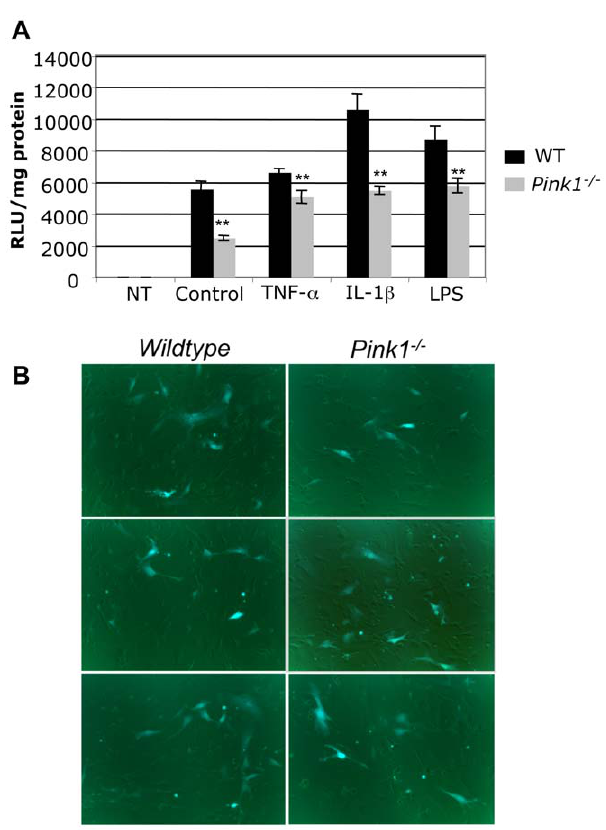
Figure 7. Basal and inflammatory signal-induced NF- k B activity is reduced in Pink1 2 / 2 embryonic fibroblasts. Wildtype and Pink1 2 / 2 MEF were transfected with plasmid pNF- k B-luc (Clontech). Twenty-four hours after transfection the cells were incubated for 8 hours with 30 ng/ml TNF- a , 10 ng/ml IL-1 b , 100 ng/ml LPS or remained untreated (control) and luciferase activity was measured